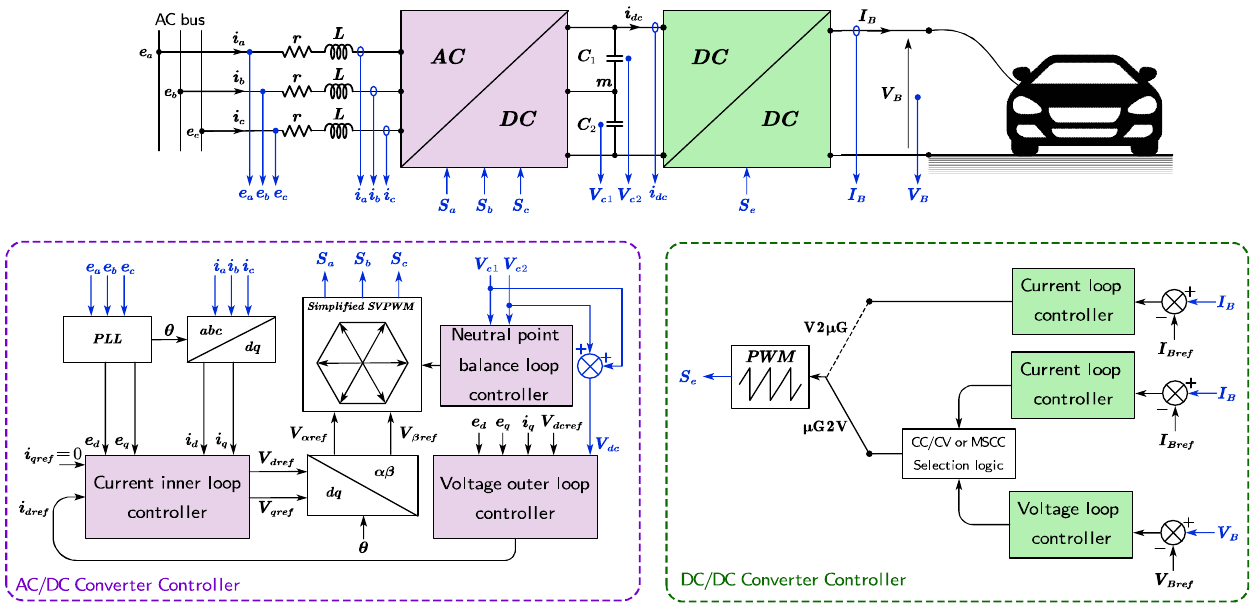
Figure 16. A control structural scheme of the ultra-fast charger integrated into the AC microgrid.